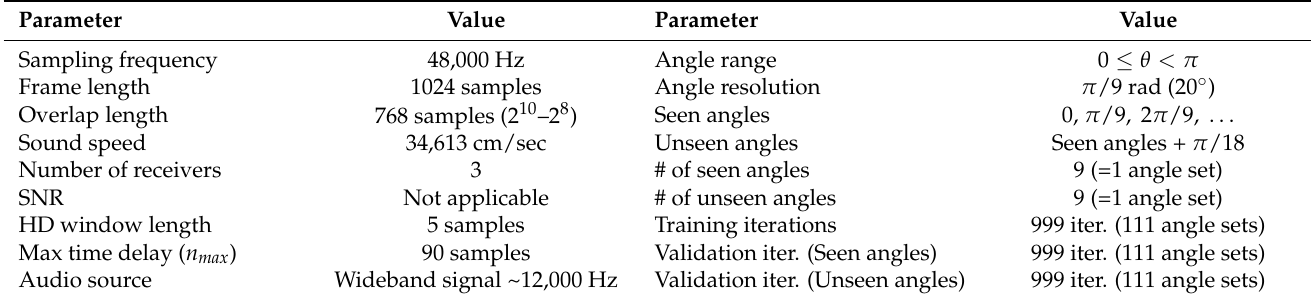
Table 4. Experiment parameters and